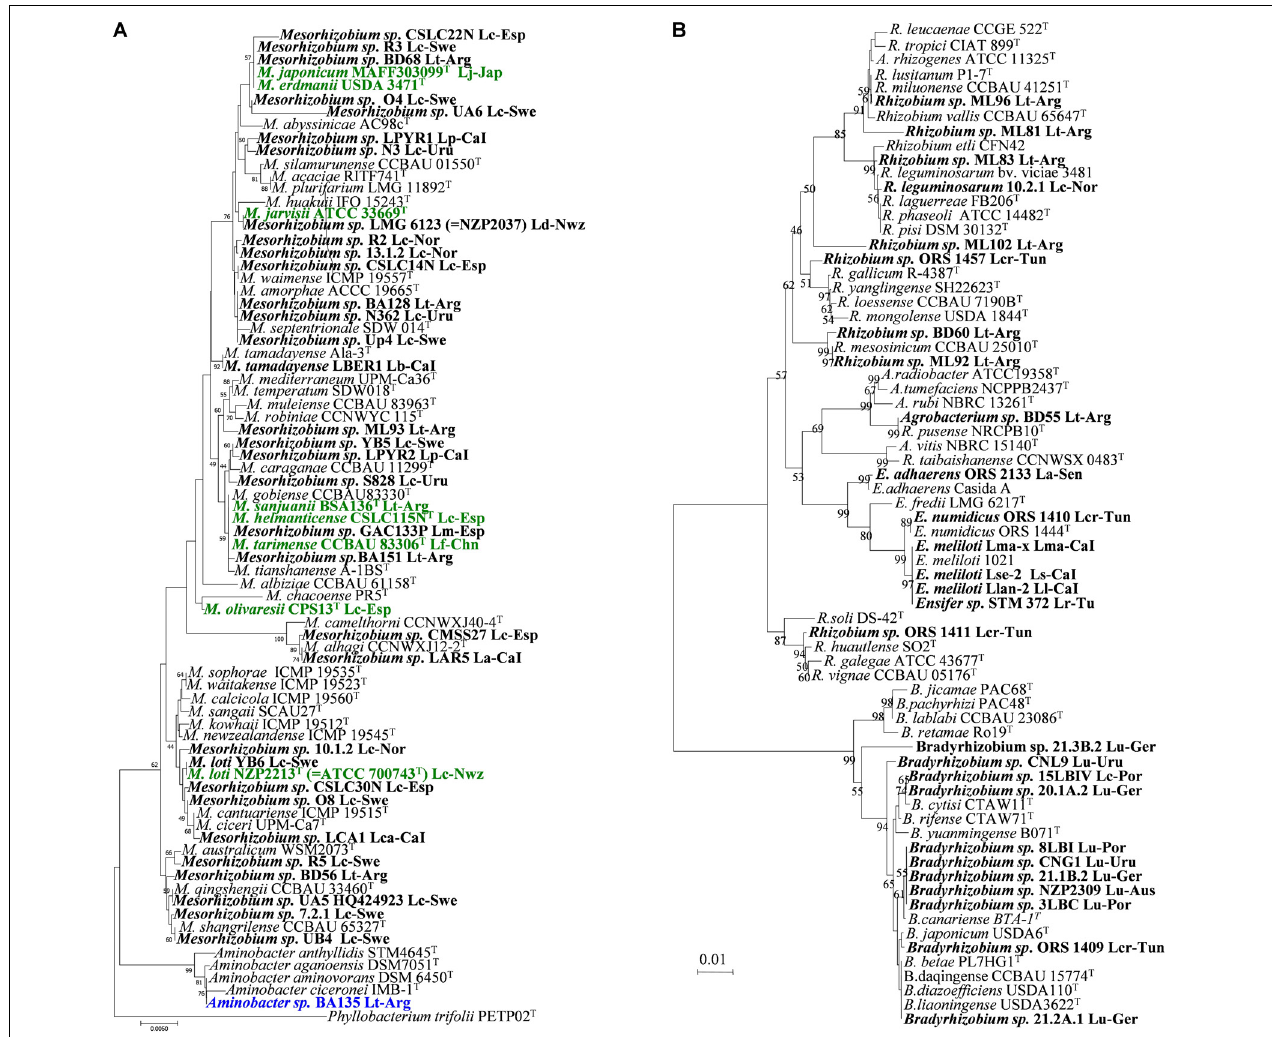
FIGURE 1 | Taxonomy and phylogeny of rhizobial symbionts of Lotus spp. 16S rRNA phylogenetic tree including genera Mesorhizobium and Aminobacter (A) , and Bradyrhizobia, Ensifer ( Sinorhizobium ) and Rhizobium (B) . Bold names correspond to Lotus rhizobia, with original Lotus species and country of isolation indicated. In bold green are rhizobial species which have Lotus symbionts as type strains. Analyses were conducted with MEGA using Neighbor Joining Maximum Likelihood (NJML). A total of 1224 positions were used in the final dataset. La, L. arinagensis ; Lar, L. arabicus; Lb, L. berthelotii ; Lc, L. corniculatus ; Lca, L. campylocladus ; Lcr, L. creticus ; Lf, L. frondosus ; Lk, L. kunkelii ; Lj, L. japonicus ; Ll, L. lancerottensis ; Lm, L. maritimus ; Lma, L. maculatus ; Lp, L. pyranthus . Lr, L. roudairei ; Ls, L. sessilifolius ; Lt, L. tenuis ( L. glaber ) ; Lu, L. uliginosus ( L. pedunculatus ). Arg, Argentina; Aus, Australia; Bel, Belgium; CaI, Canary Islands; Chn, China; Esp, Spain; Ger, Germany; Jap, Japan; Nor, Norway; Nwz, New Zealand; Por, Portugal; Sen, Senegal; Swe, Sweden; Tun, Tunisia; Uru, Uruguay. Accessions numbers for all sequences used in this review are listed in Supplementary Table S1